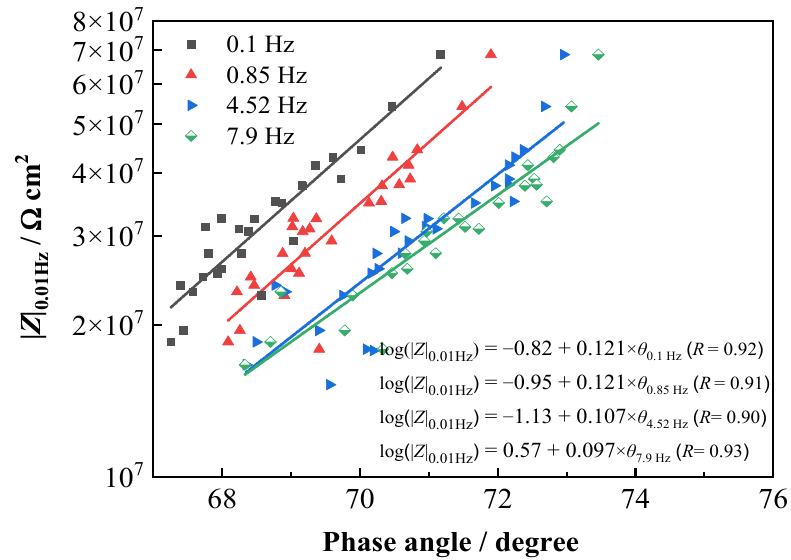
Figure 10. Fitting results of | Z | 0.01Hz and several phase angles in middle-frequency range for T700/BMI specimen. Because the measurement in lower frequency takes longer time than that in higher frequency, in terms of the need for rapid detection in field applications, it is suggested to use that testing of the phase angle around 10 Hz ( θ 10Hz ) to evaluate the performance of the carbon fiber-reinforced polymer composites instead of testing the low-frequency impedance (| Z | 0.01Hz ). Figure 11 shows the variations of | Z | 0.01Hz and the phase angle at 10 Hz ( θ 10Hz ) with testing time for two carbon fiber-reinforced polymer composites. For each composite material, the curve of θ 10Hz shows a very similar decreasing tendency to that of the | Z | 0.01Hz . That is, the phase angle at 10 Hz ( θ 10Hz ) shows a high correlation with the | Z | 0.01Hz . Therefore, θ 10Hz could be suggested to quickly detect and evaluate the performance of carbon fiber-reinforced polymer composites in 3.5% NaCl immersion.